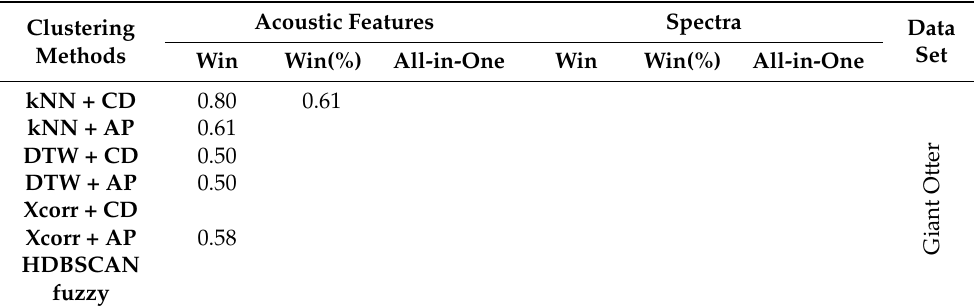
Table 2. NMI values of the comparison between the labeling of the different clustering methods and the actual allocation of vocalizations to the corresponding giant otter individuals. The allocation was not human-rated, but could be determined by sound localization. Only those NMI values that were achieved by clustering methods that met the threshold values for both NMI and ∆ -Cluster are shown.